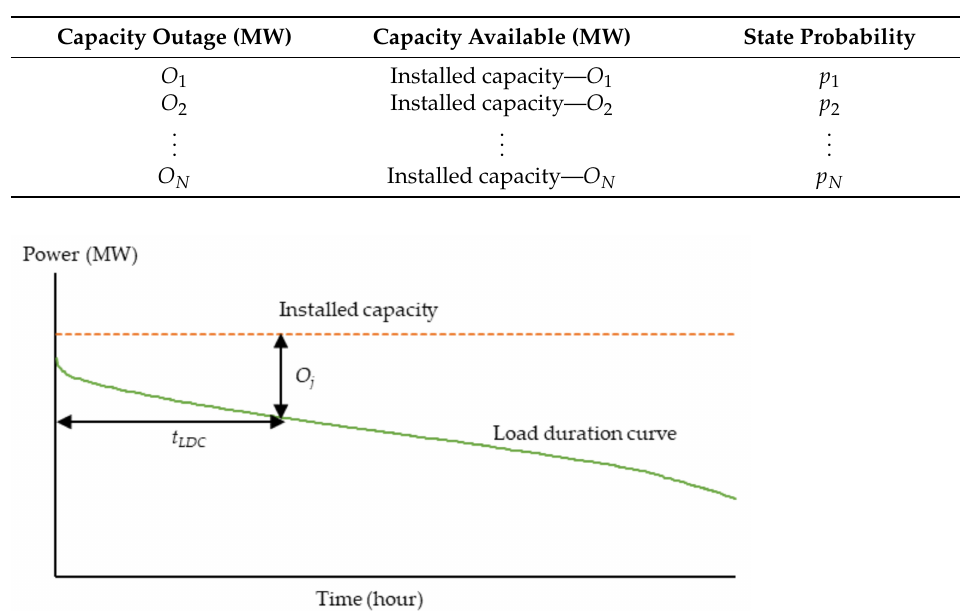
Table 1. Example of a Capacity Outage Probability Table.